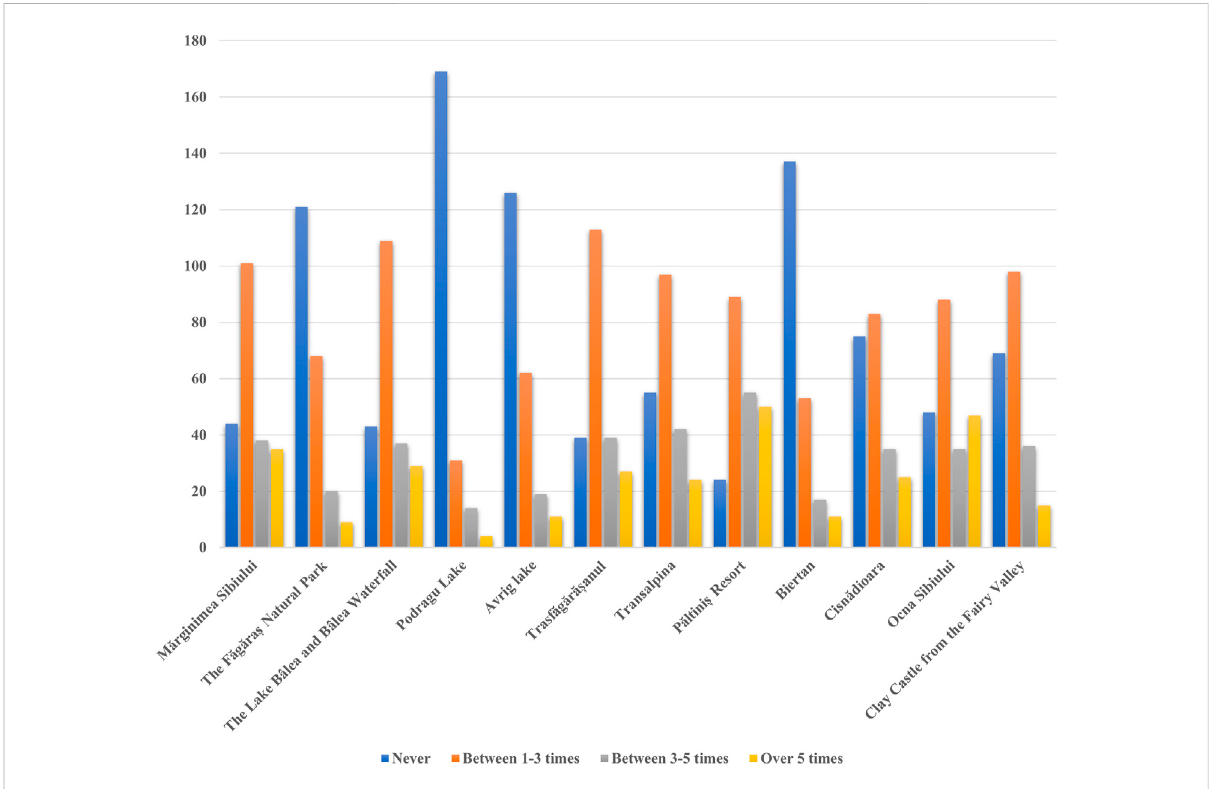
FIGURE 7 Frequency of visiting ecotourism destinations in Sibiu County in 2020 and 2021.